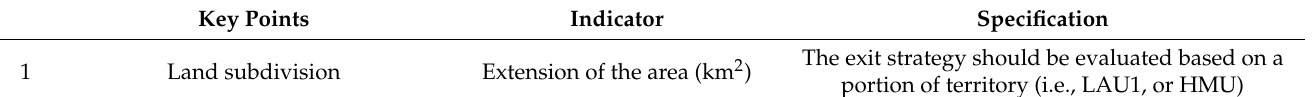
Table 1. The eight main EFSA scientific opinion founding [9] are identified by the main scientific key points and summarized as the indicator and the specification of these